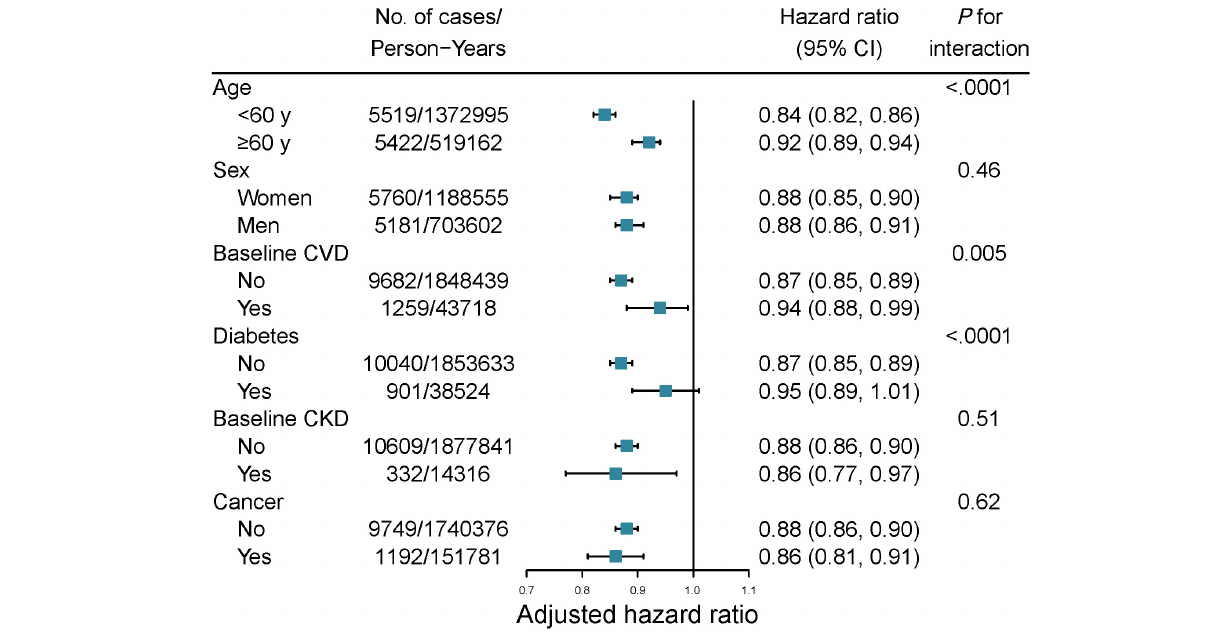
FIGURE 2 | Subgroups analysis of the healthy sleep score with incident hypertension in UK Biobank. The models were fully adjusted for age, sex, ethnicity, education, Townsend deprivation index, household income, baseline mean arterial pressure, alcohol consumption, healthy lifestyle categories, family history of hypertension, baseline cardiovascular disease, diabetes, chronic kidney disease, and cancer.